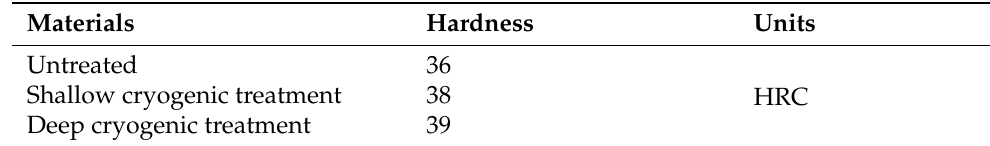
Table 4. Average hardness values of the samples.